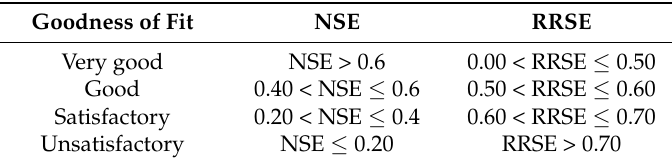
Table 1. Classification of goodness of fit for NSE and RRSE.